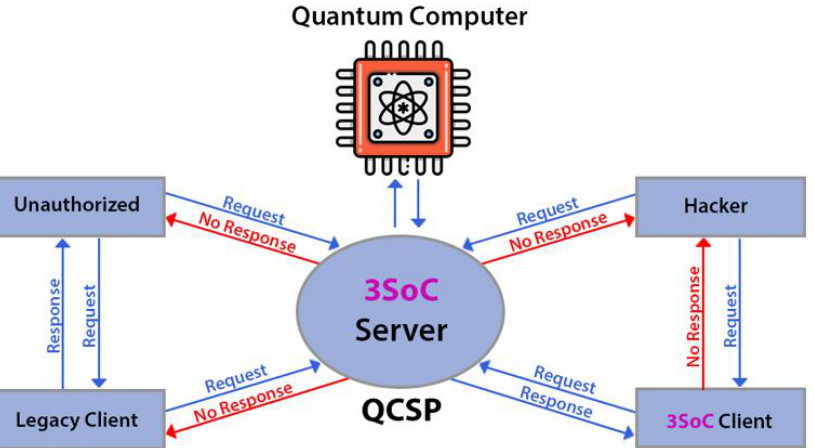
Figure 7. Quantum computer service provider (QCSP) providing quantum computing via 3SoC Intranet to subscribers.